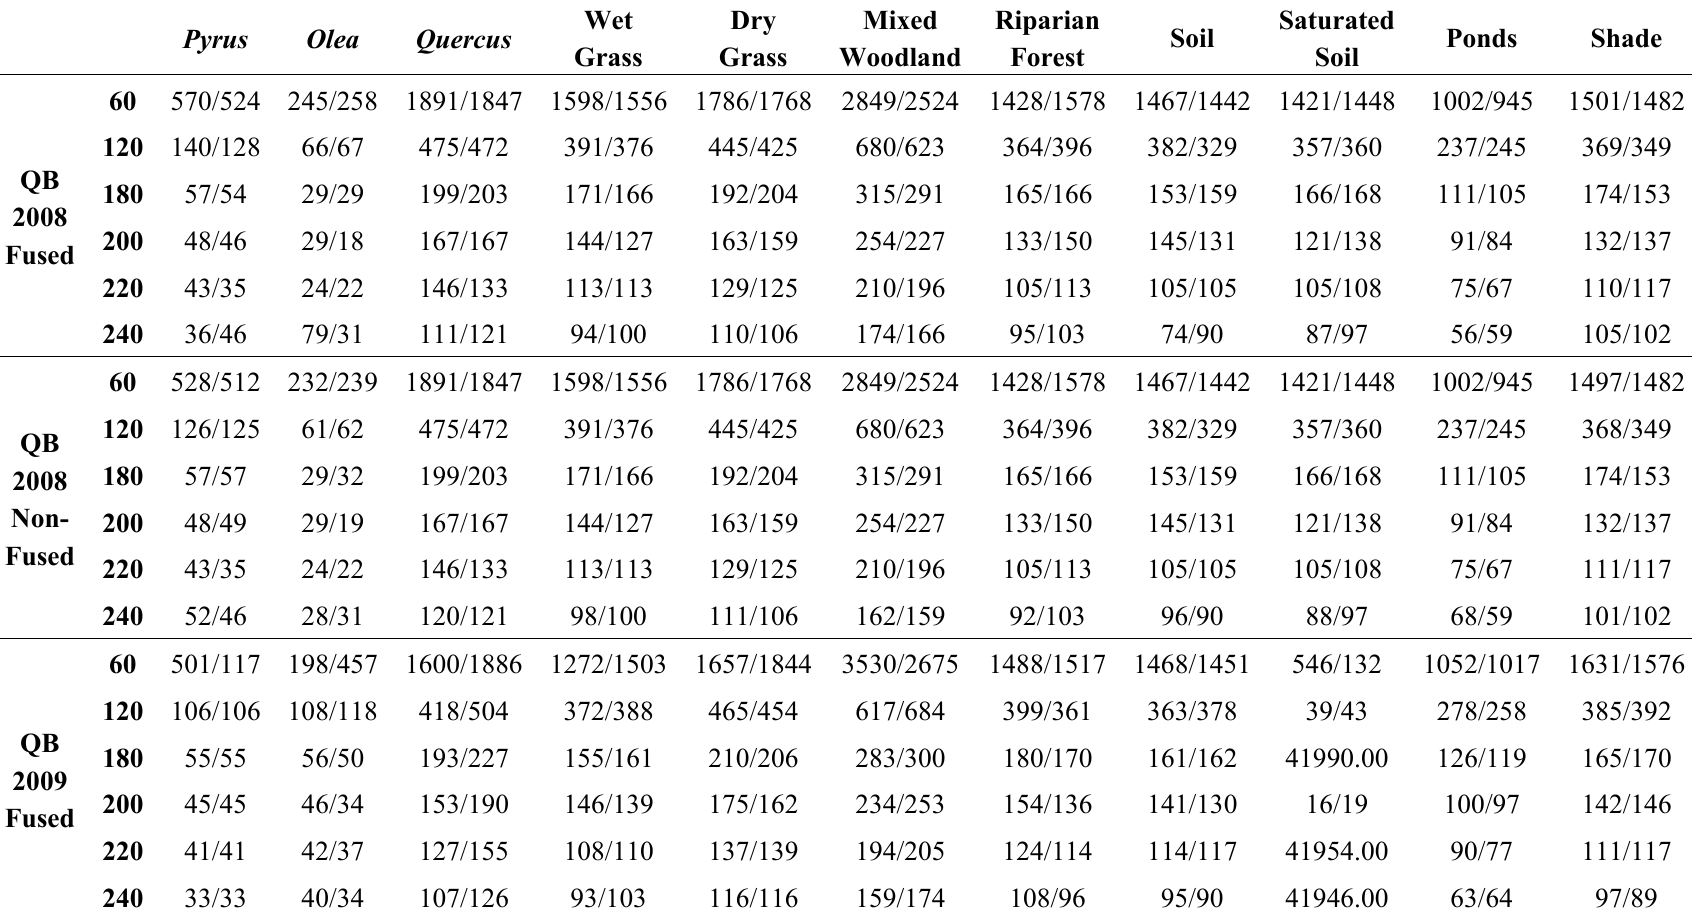
Pyrus Olea Quercus